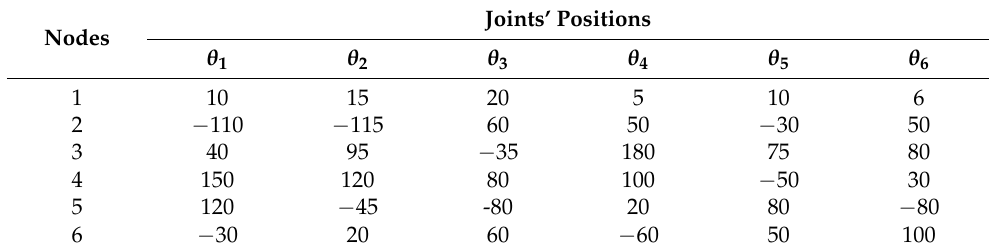
Table 4. Sequence of joint’s positions.